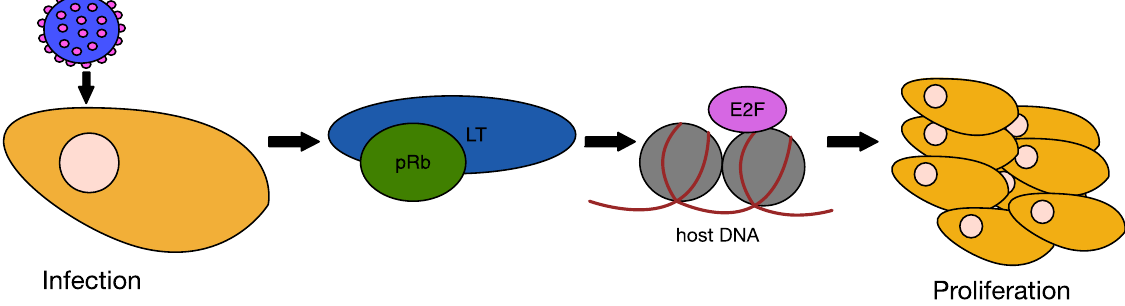
Figure 8. Effect of LT on cell proliferation. Upon MCPyV infection and T antigen expression, LT binds the regulatory protein pRb, thus inactivating it. This allows E2F to activate the transcription of cell cycle progression-associated genes, which switches the cell into S-phase and leads to cell